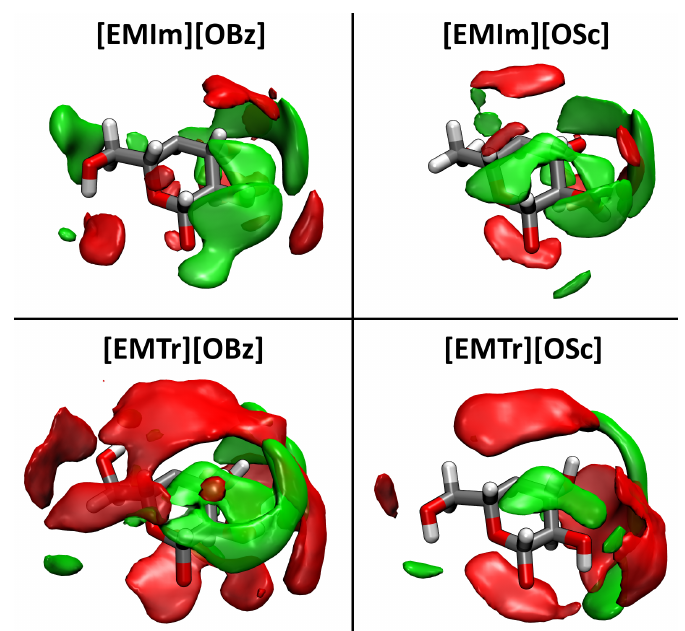
Figure 9. Spatial distribution functions (SDF) of H(Ring) (red, 7nm − 3 ) and O(Car) (green, 14nm − 3 ) around one monomer unit of the cellulose strand; averaged over all monomer